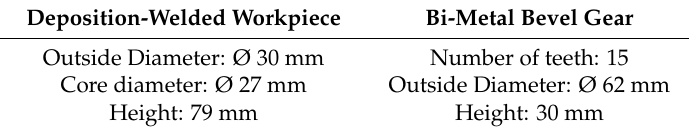
Table 1. Geometrical parameters of the bi-metal workpieces and bevel gears.